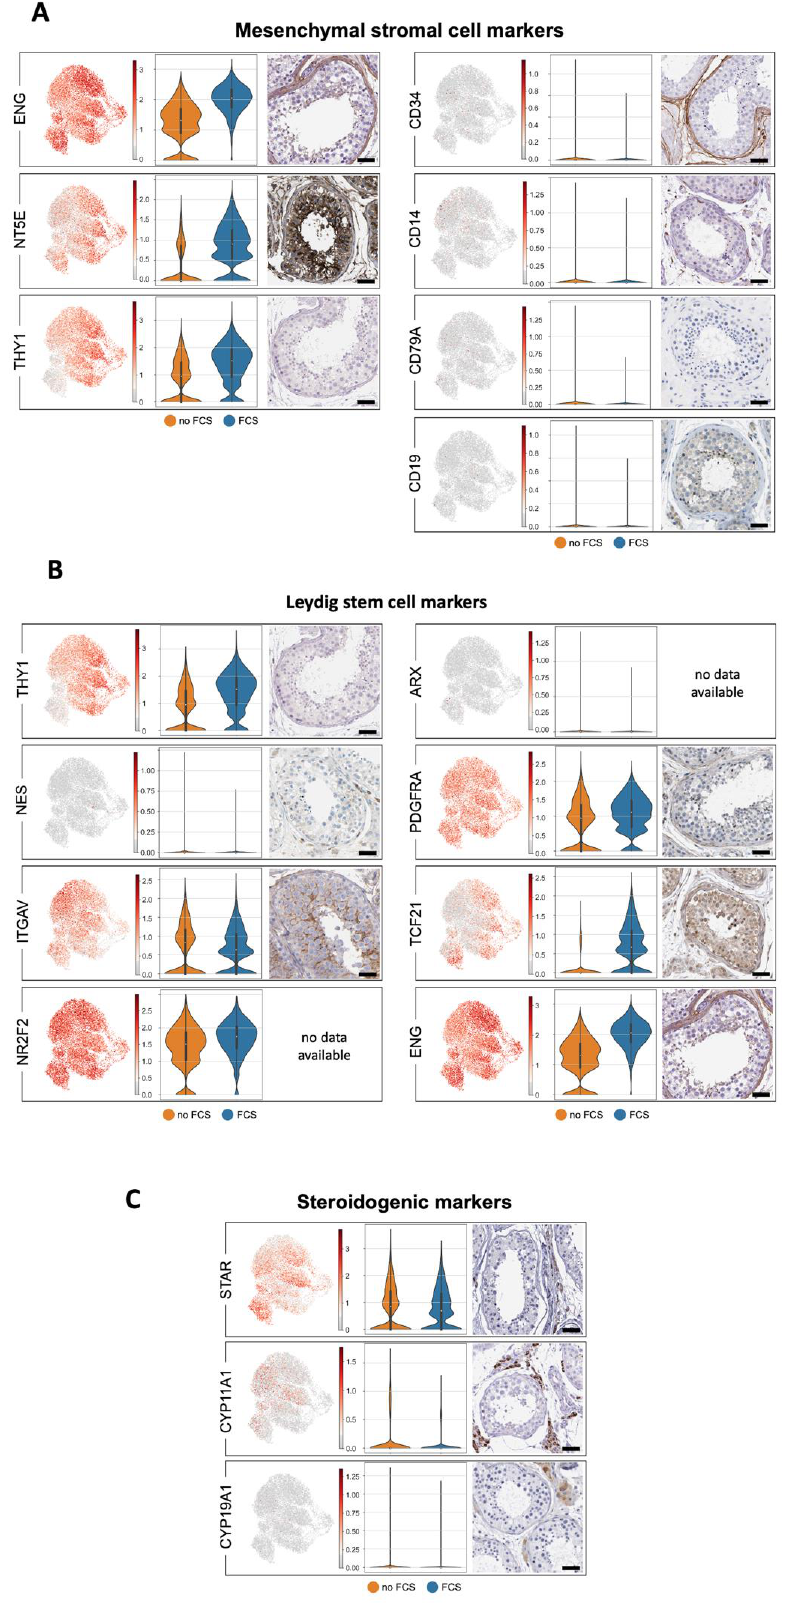
Figure 7. Markers of mesenchymal stromal cells, Leydig stem cells and steroidogenic enzymes. ( A – C ): UMAP plots of prototype smooth muscle markers in HTPCs ( left side ). Violin plots